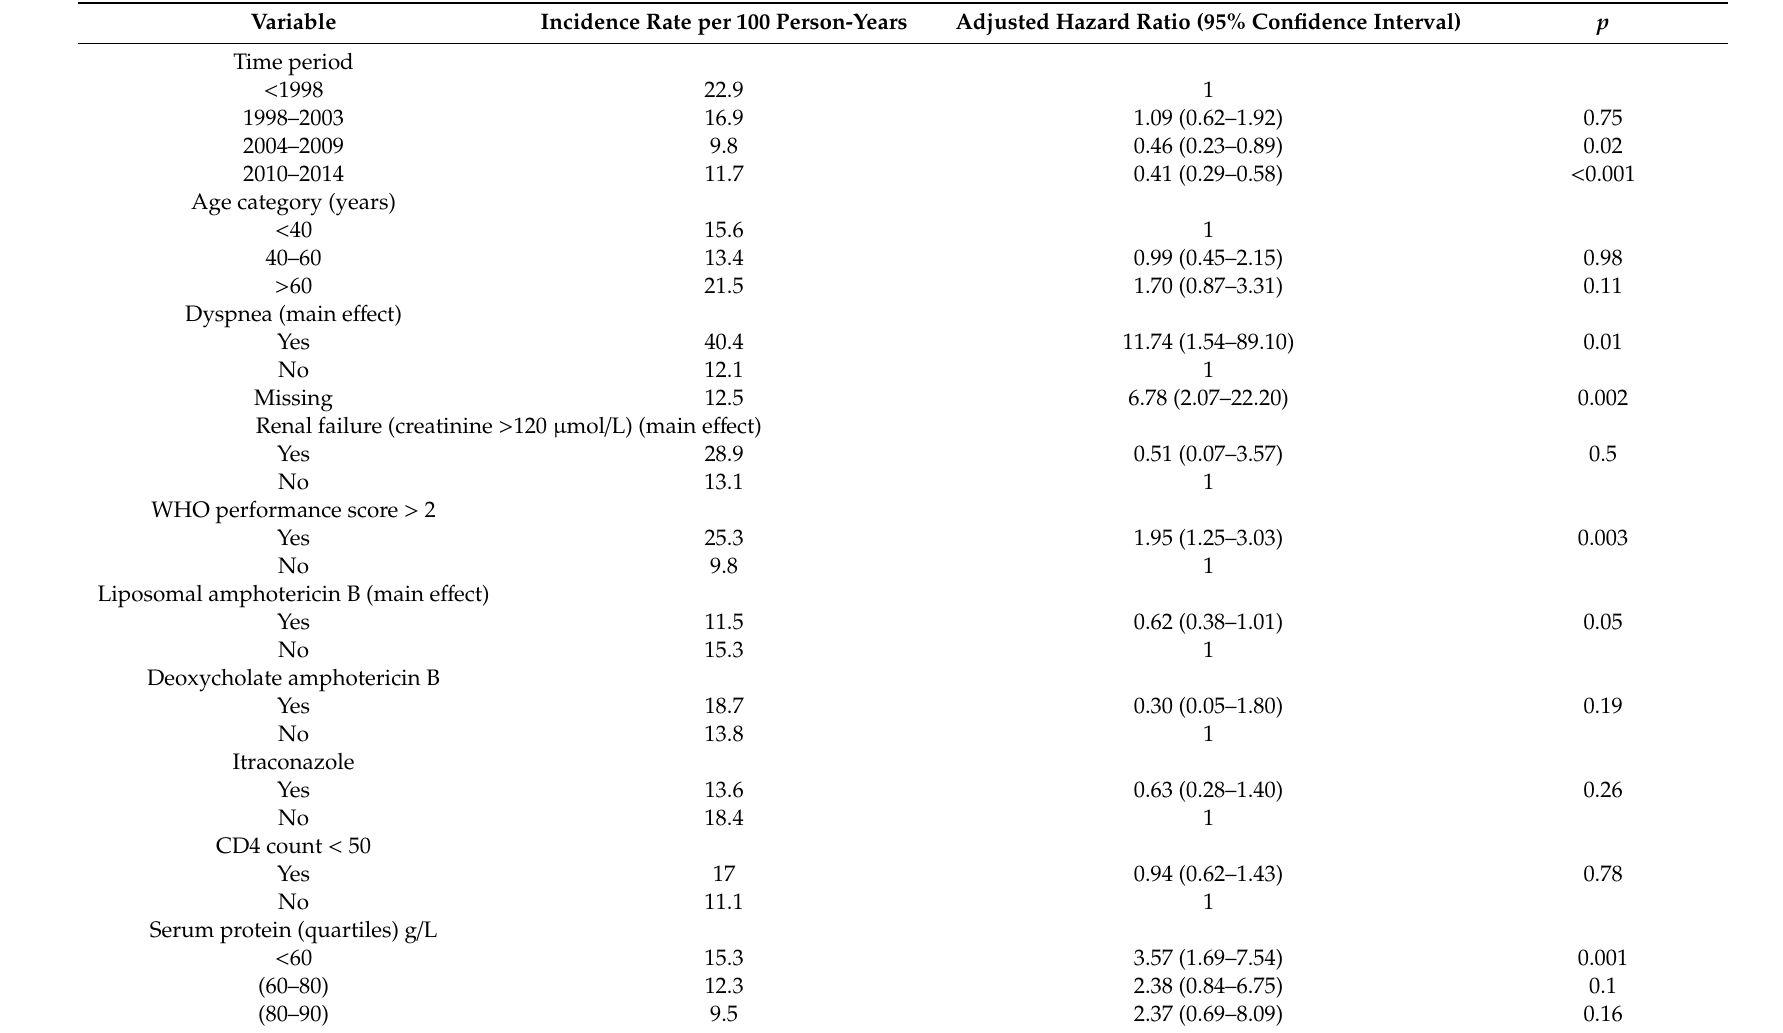
Table 2. Adjusted hazard ratios for death among HIV-infected patients with confirmed disseminated histoplasmosis.